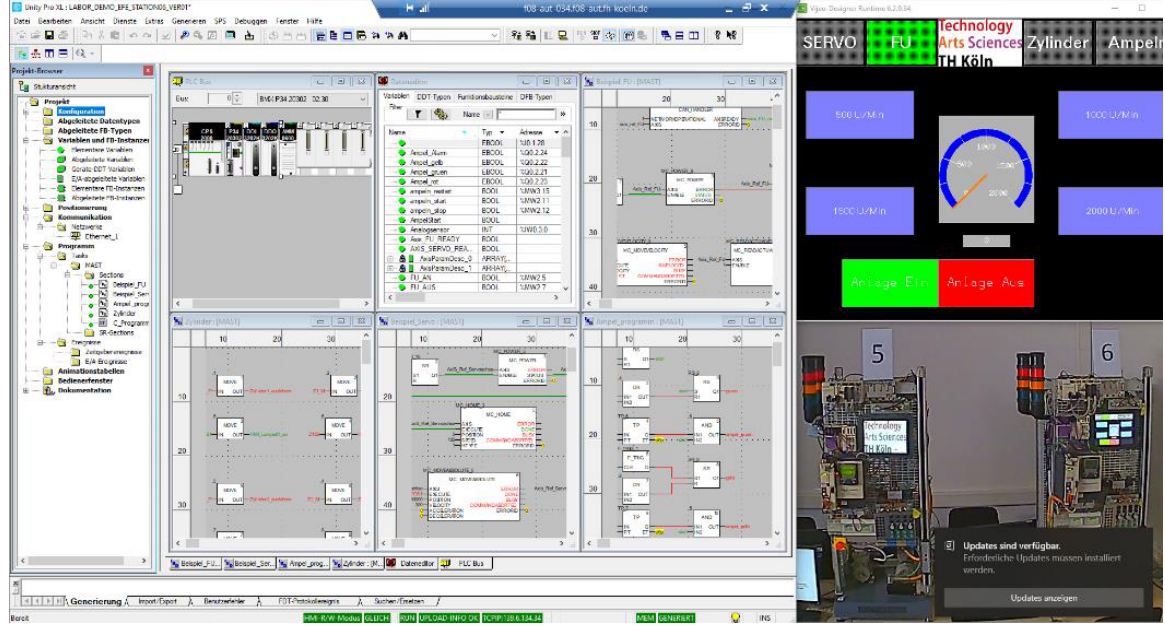
Figure 5. Software tools, testing and validation of programs